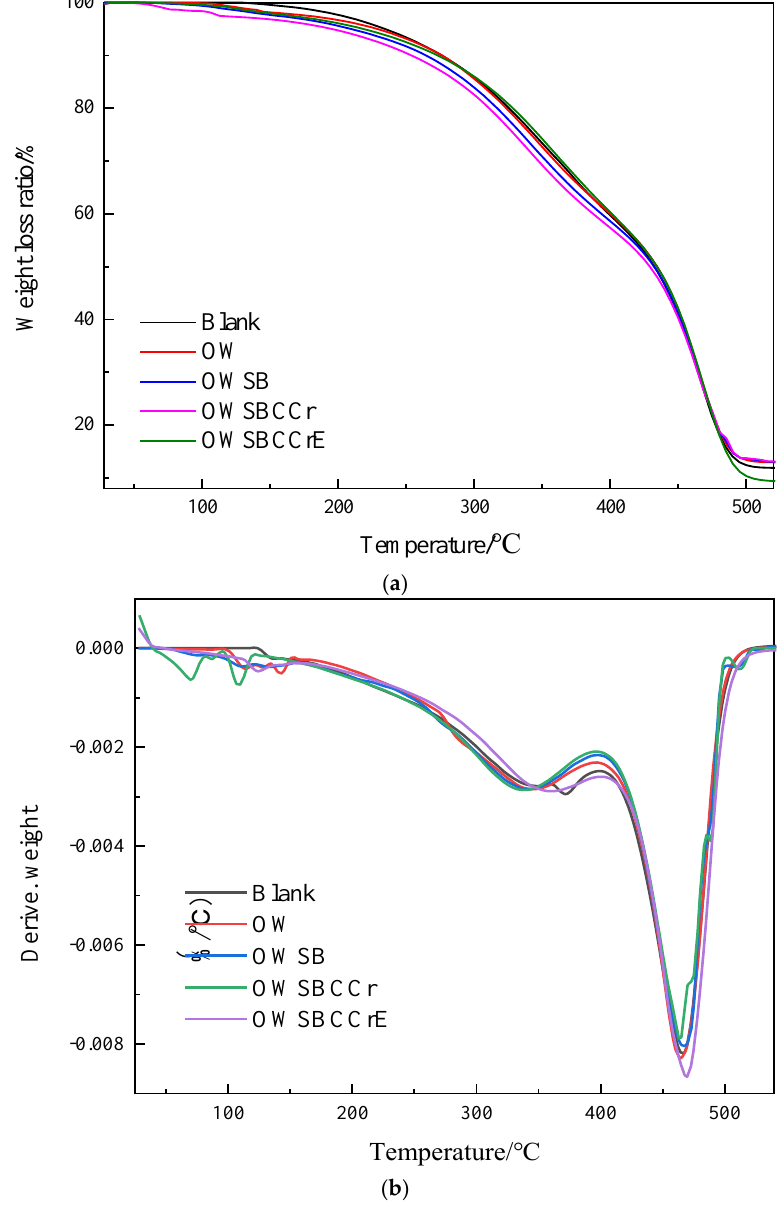
Figure 11. L8401 heavy oil under different reaction conditions: ( a ) TGA curve of the different oil samples, ( b ) DTG of different oil